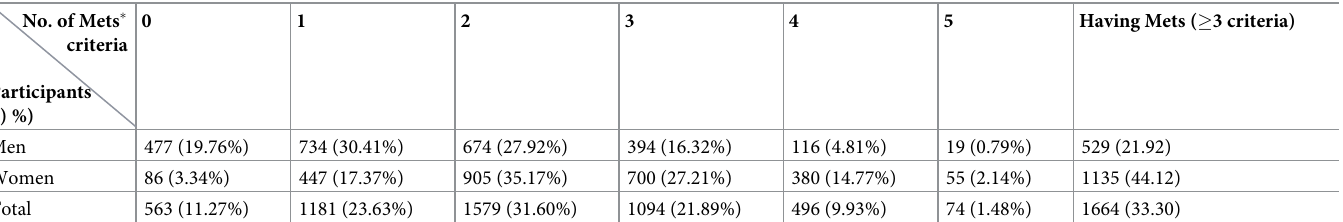
Table 4. The prevalence of metabolic syndrome (according to ATP III